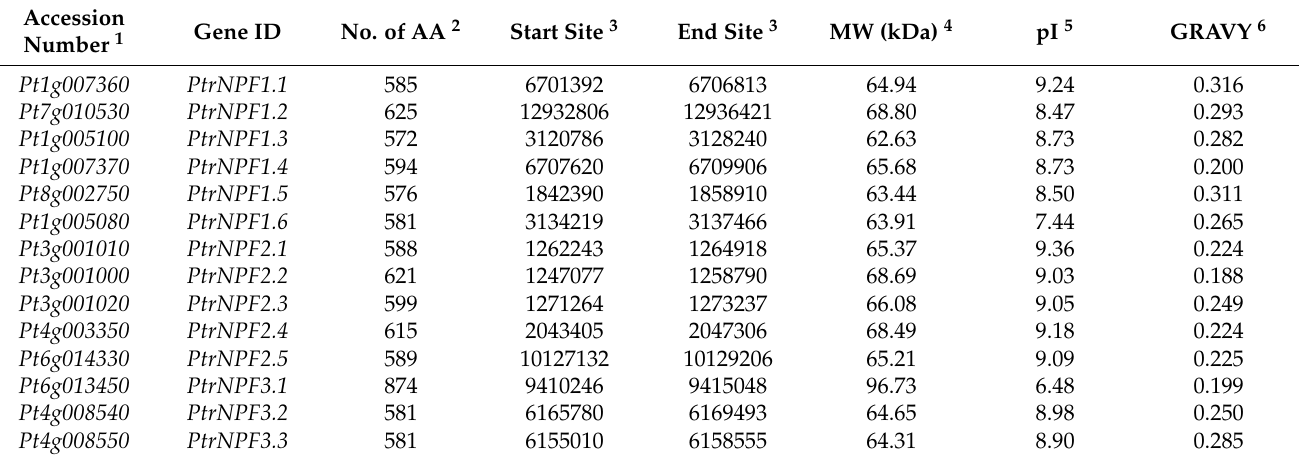
Table 1. Characteristics of PtrNRT